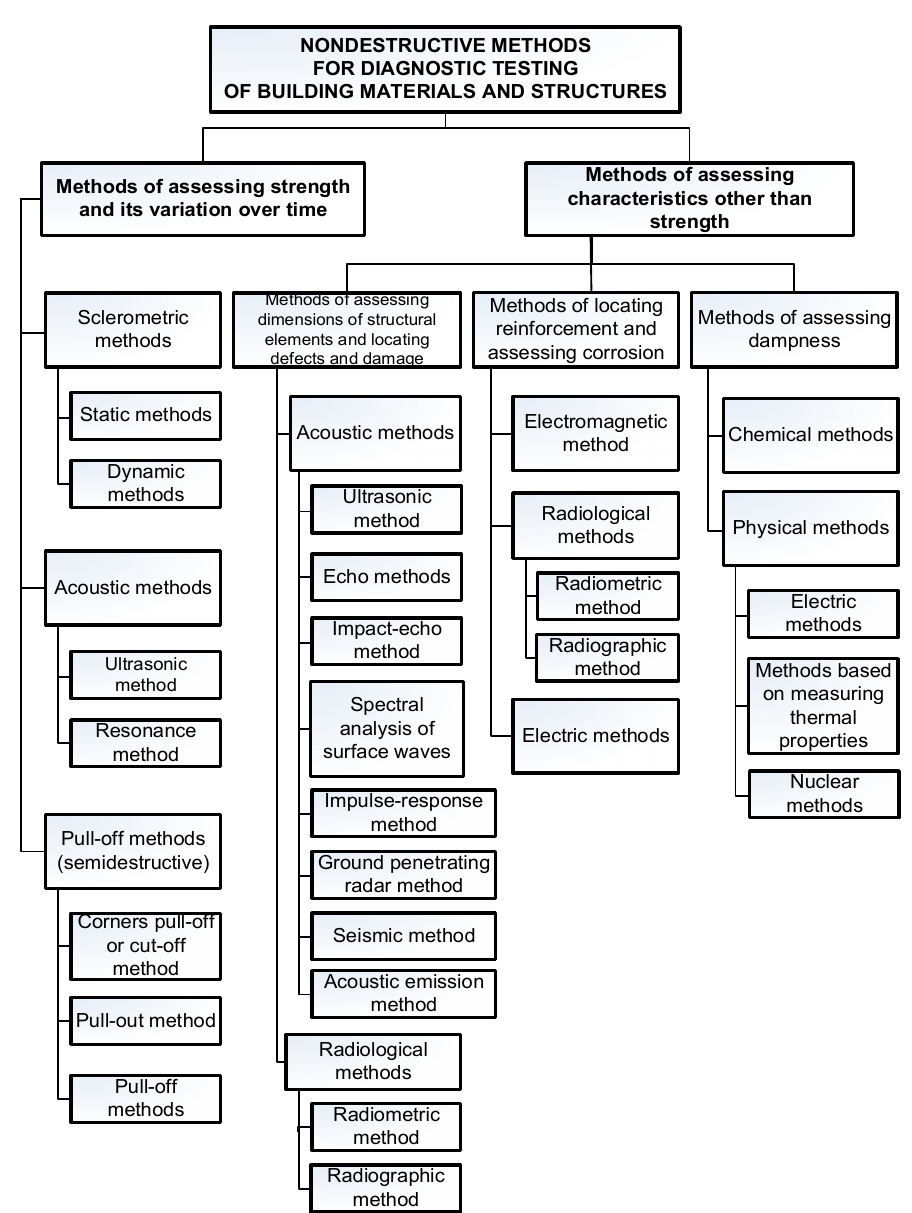
Figure 3. Non-destructive methods useful for diagnosing building structures and building materials [2,3].